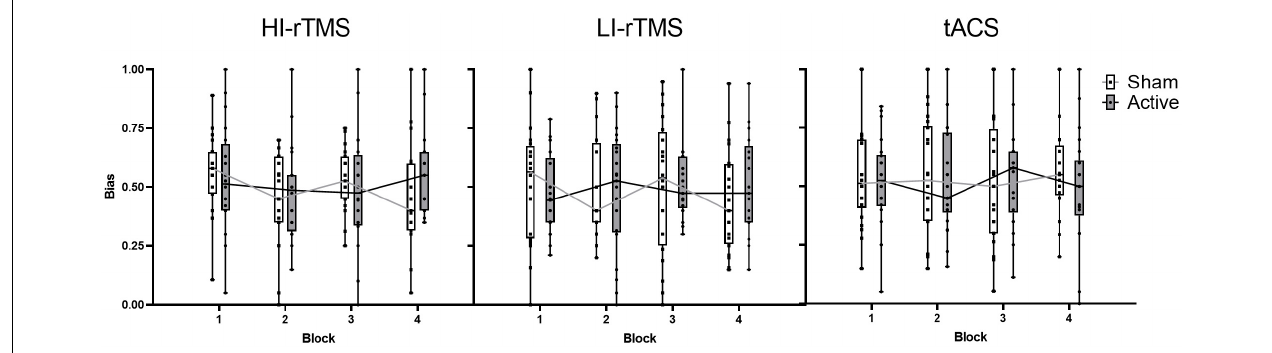
FIGURE 3 | Spatial bias scores for sham and active stimulation for each stimulation type across blocks of the line bisection task. No significant effects or interactions present. Individual points represent mean spatial bias for individual participants. For the bias score: 0 = absolute leftward bias, 1 = absolute rightward bias.